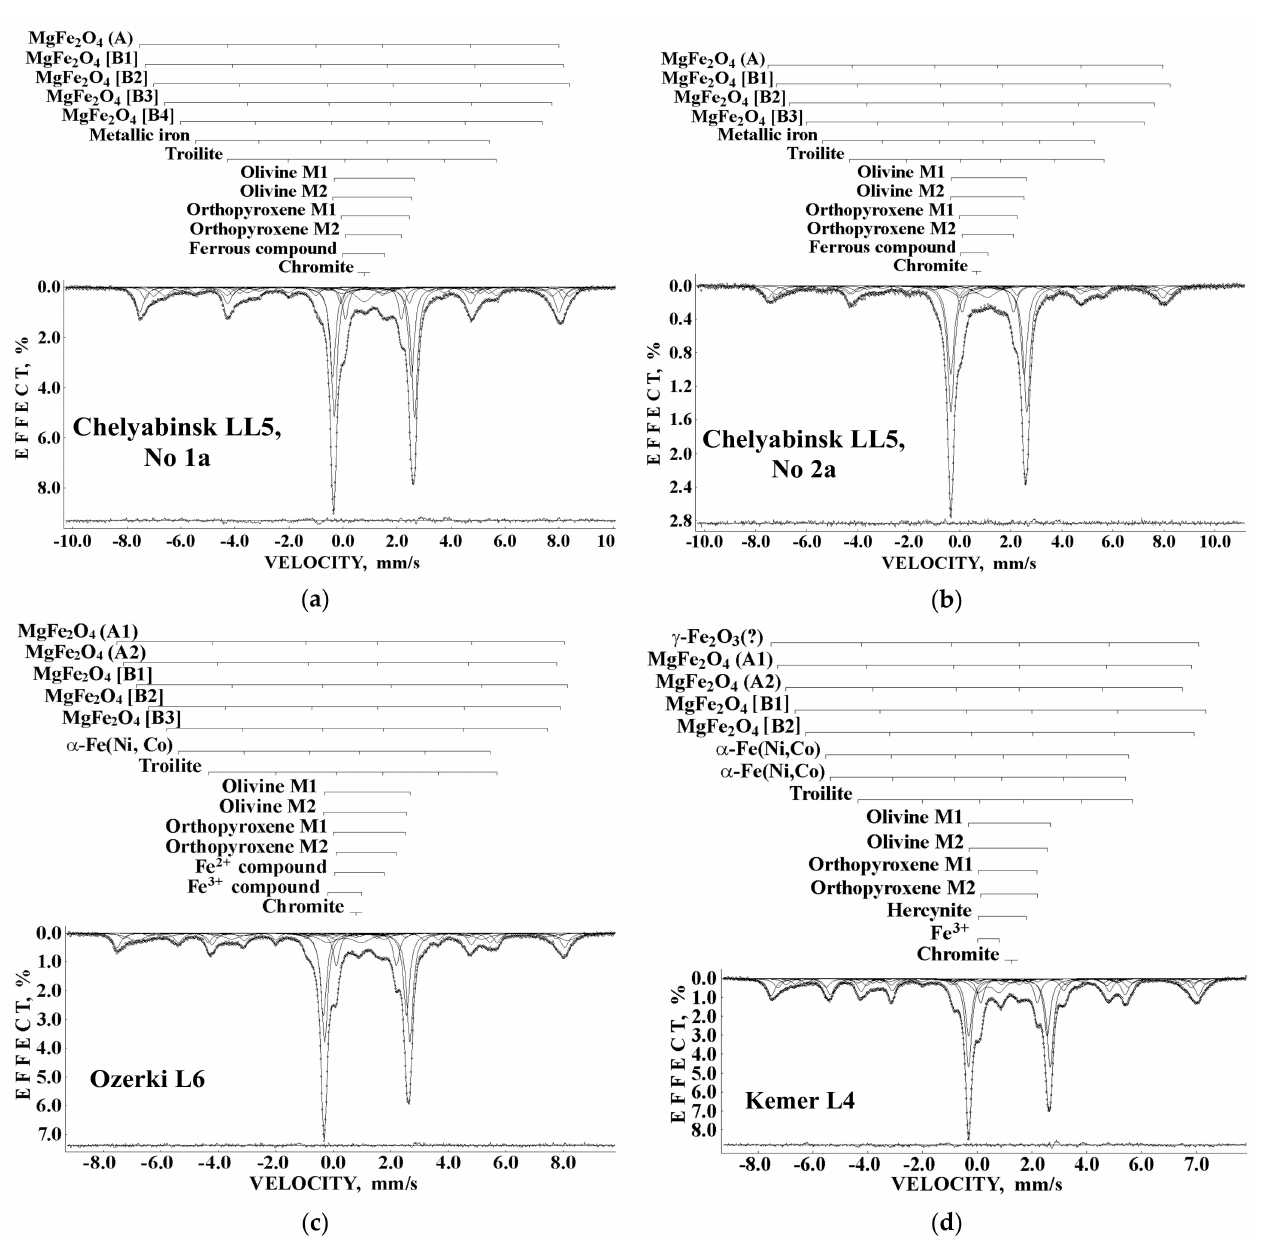
Figure 51. Room temperature Mössbauer spectra of the fusion crust from ordinary chondrites: Chelyabinsk LL5, No 1a ( a ), Chelyabinsk LL5, No 2a ( b ), Ozerki L6 ( c ), and Kemer L4 ( d ). These spectra were measured with a high velocity resolution. Indicated components are the results of the best fits. The differential spectra are shown on the bottom. Adapted from References